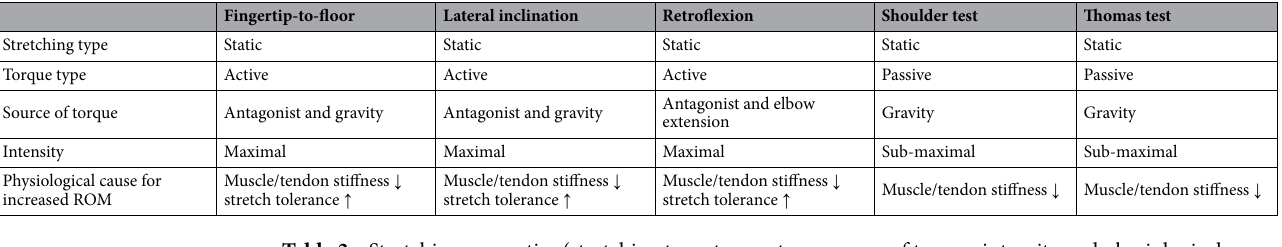
Table 3. Stretching properties (stretching type, torque type, source of torque, intensity and physiological cause for increased ROM) for each ROM